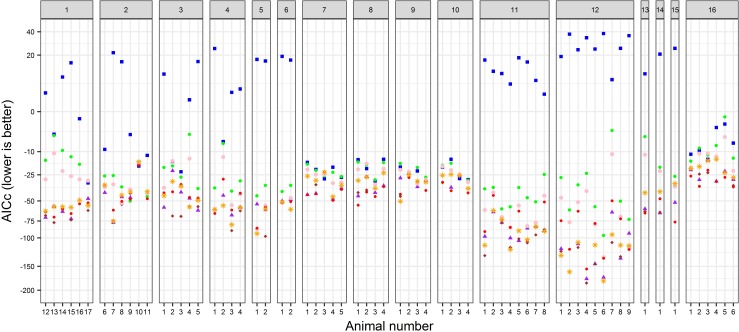
AICc values for the fit of each model to each of the 68 animals.Species groups are given in different panels with the label at the top. The legend for shapes and colors is the following: blue square = S1, green dot = S2, purple triangle = S3, purple diamond = S4, ● = C2, red dot = C3, orange asterisk = MP.